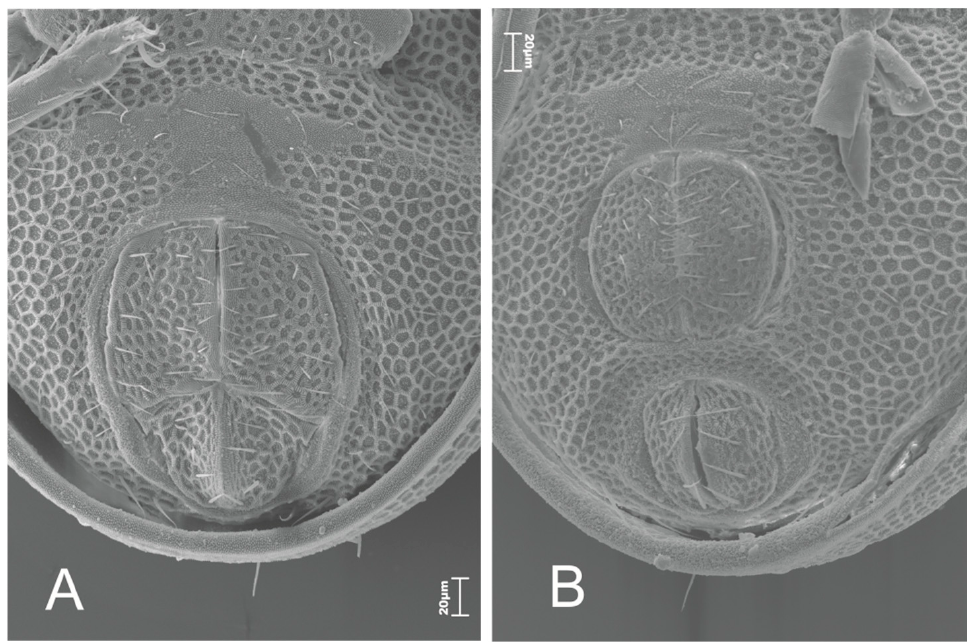
Figure 4. Sexual dimorphism of L. luteum : ( A )—female; ( B )—male. SEM observations. On each side of the body there are gland-like organs and simple eyes, which are characteristic of many mite species from this group (Figure 5A).